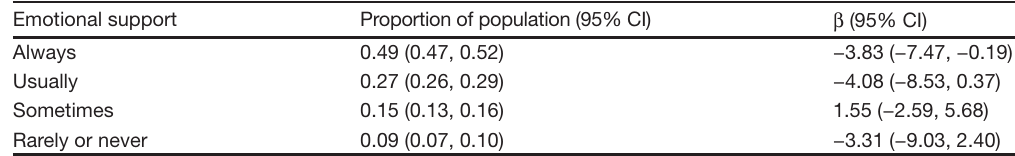
Table 6. Associations between oil spill cleanup participation and anxiety, by frequency of emotional support, in communities participating in the GSPS Emotional